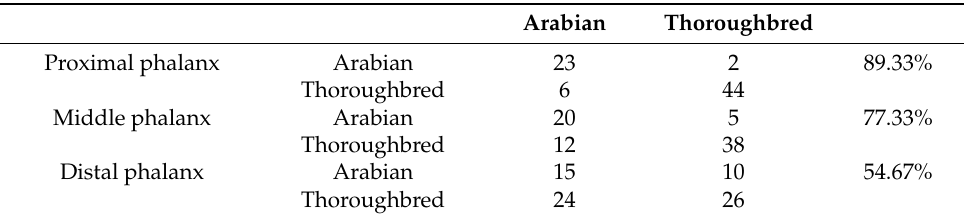
Table 4. Confusion matrix. Percentage of initial classifications that were correct, shown by